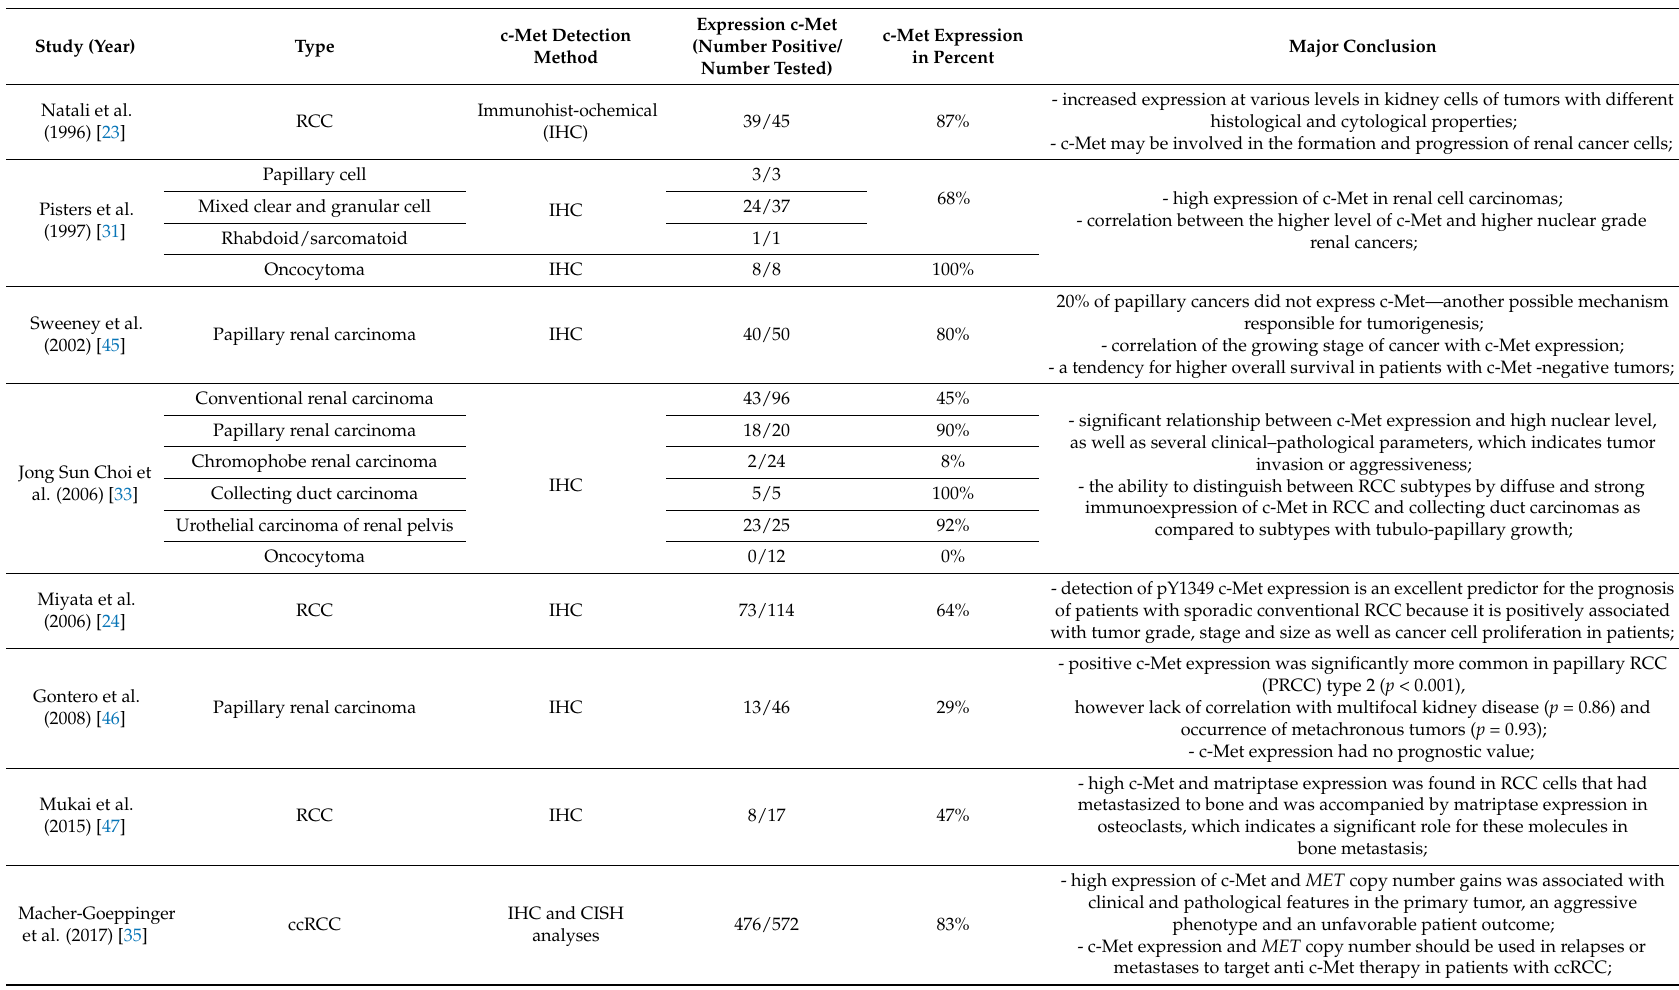
Table 1. C-Met expression and phosphorylation in renal cell carcinomas (RCC) subtypes. The correlation between c-Met expression, protein level, receptor activation and different stages of the tumor progression in patients with